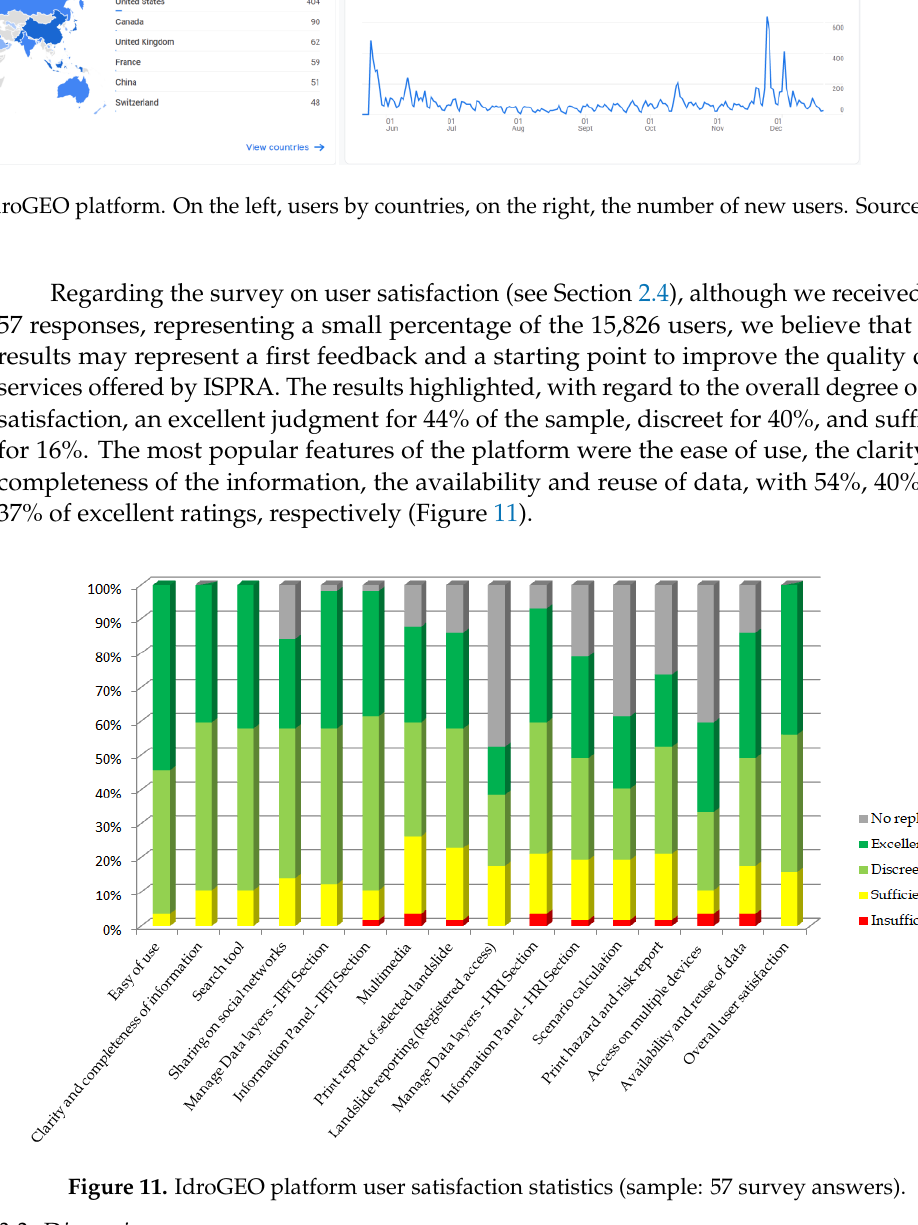
Figure 11. IdroGEO platform user satisfaction statistics (sample: 57 survey answers).